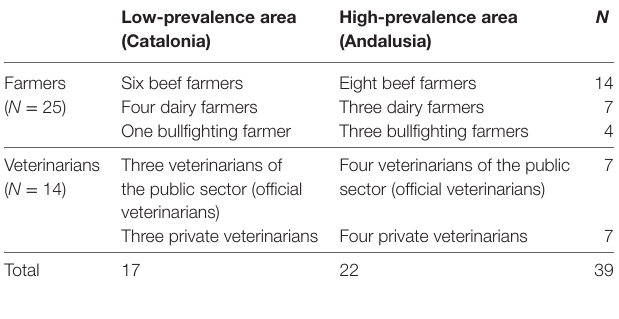
TaBle 1 | Structure of the sample for the qualitative in-depth